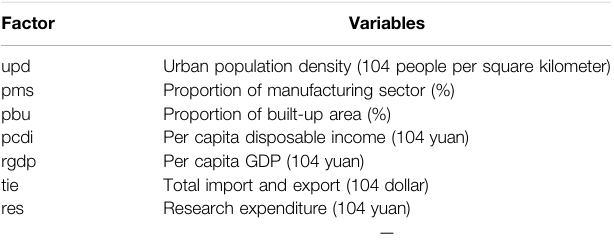
TABLE 2 | List of variables for the analysis of the factors driving industrial environmental ef fi ciency. Factor